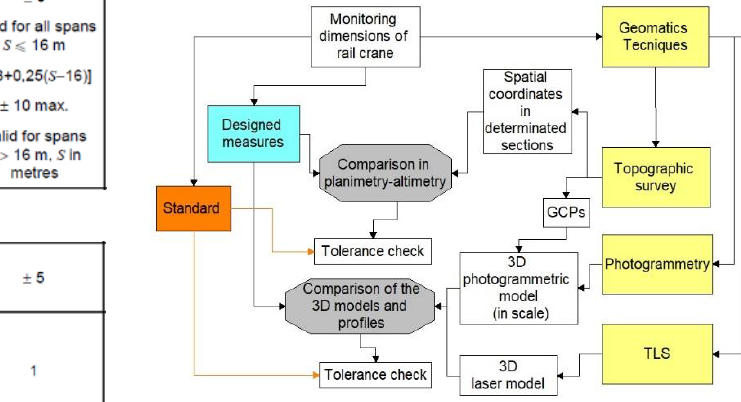
Figure 3. Pipeline of the applied